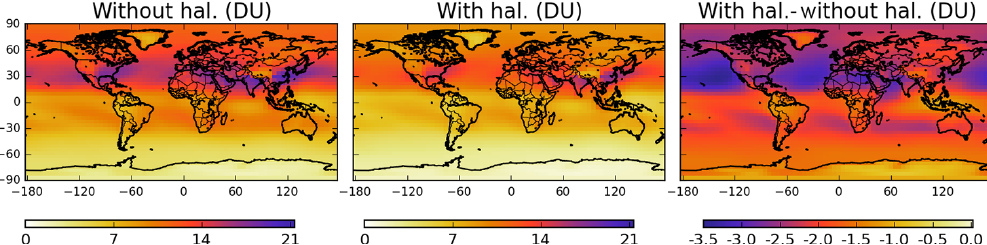
Figure 6. Increases in tropospheric O 3 column between the preindustrial and present day without and with halogens. Left and centre panels show the difference in annually averaged column O 3 (DU) between preindustrial and the present day without (left) and with halogens (centre). Right panel shows the